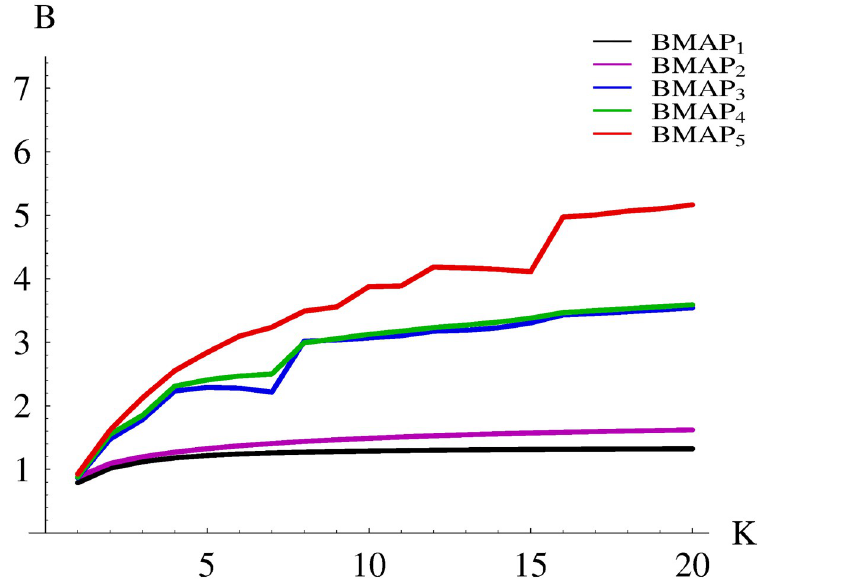
Fig 2. Dependence of the burst ratio on the buffer size for different BMAPs, range